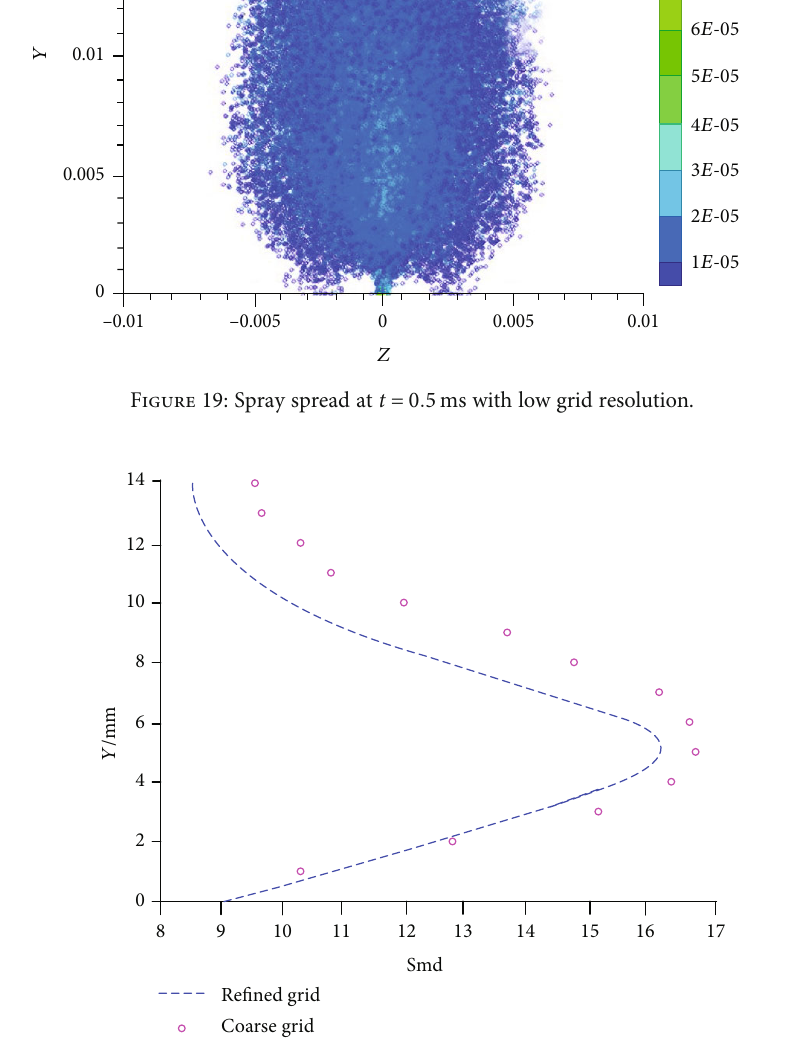
Figure 20: SMD comparison at x = 50 mm between two sets of